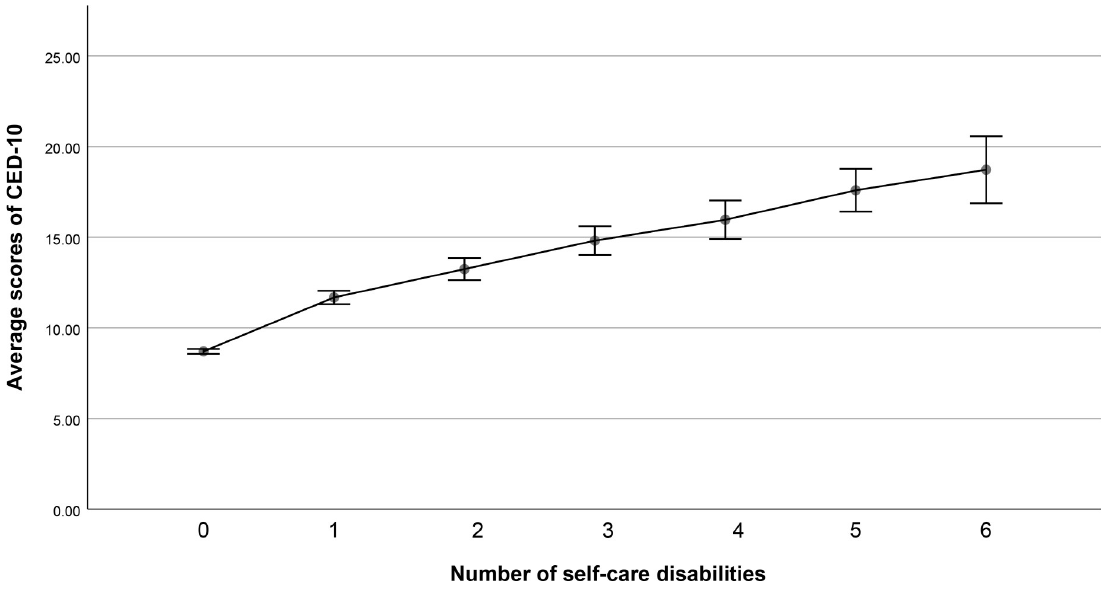
Fig 2. The relationship between the number of self-care disabilities and CESD-10